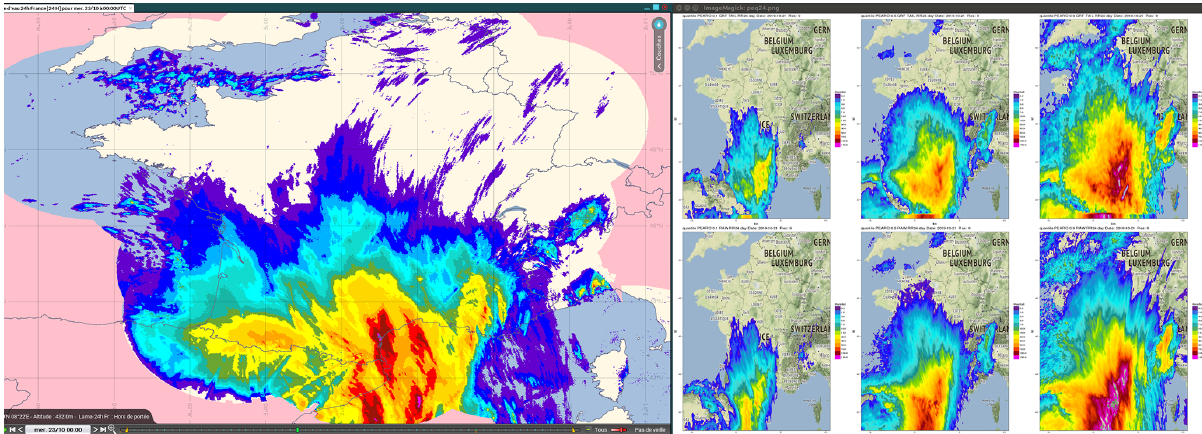
Figure 15. Illustration of a heavy precipitation event. On the left, rainfall accumulated on 22 October 2019, with peaks over 300mm. On the right, quantiles of order 0.1, 0.5, and 0.9 of post-processed (on top) and raw (on bottom) daily rainfall distributions (right maps’ data © Google